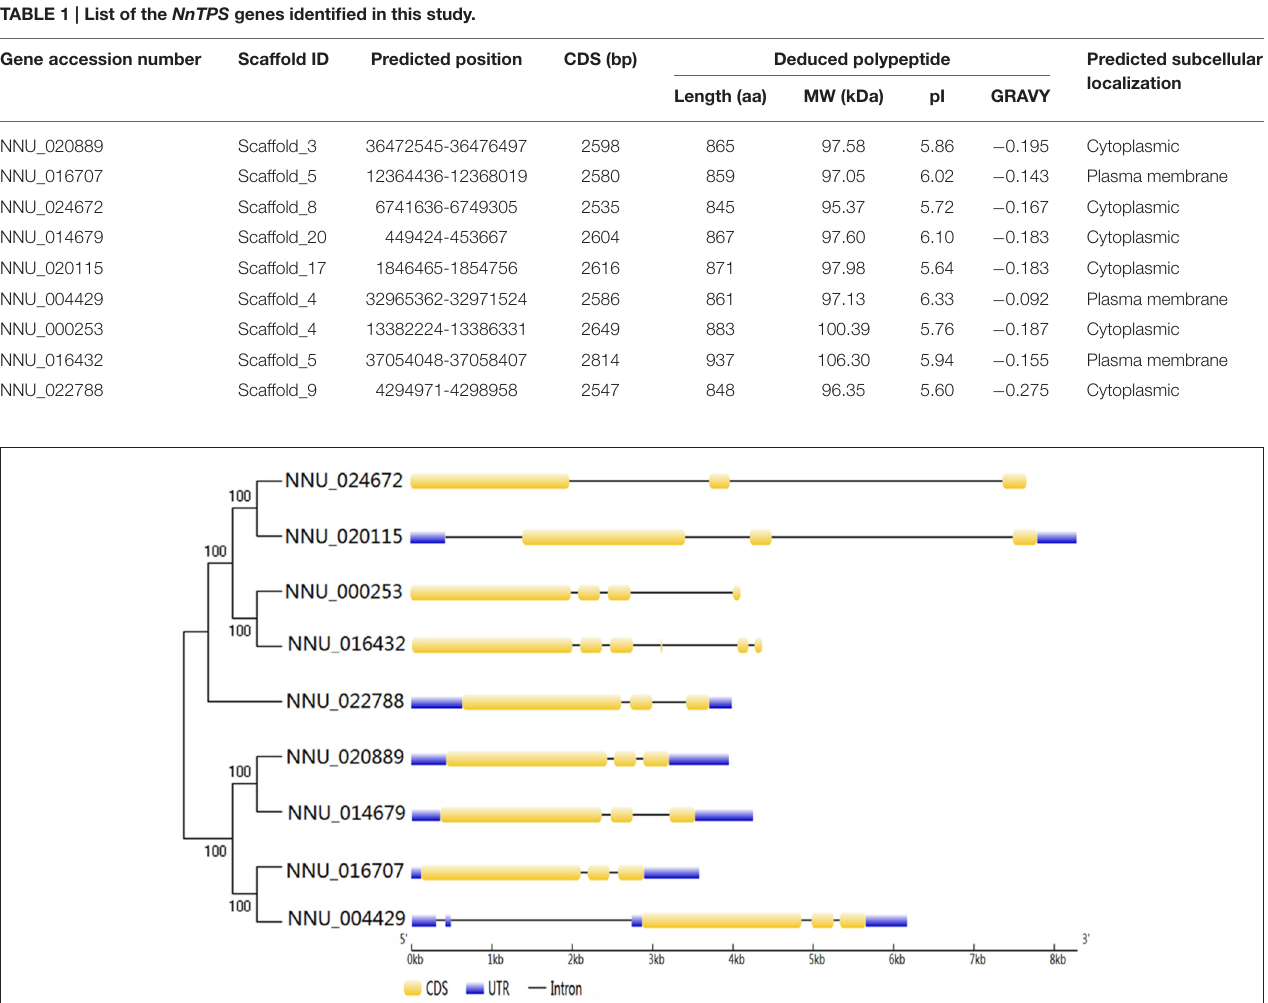
FIGURE 1 | Structure and phylogenetic analysis of NnTPS proteins. The unrooted phylogenetic tree resulting from the full-length amino acid alignment of all the NnTPS proteins is shown on the left side of the figure. Exon-intron structures of the identified NnTPS genes are shown on the right side. The graphic representation of the optimized gene model displayed using